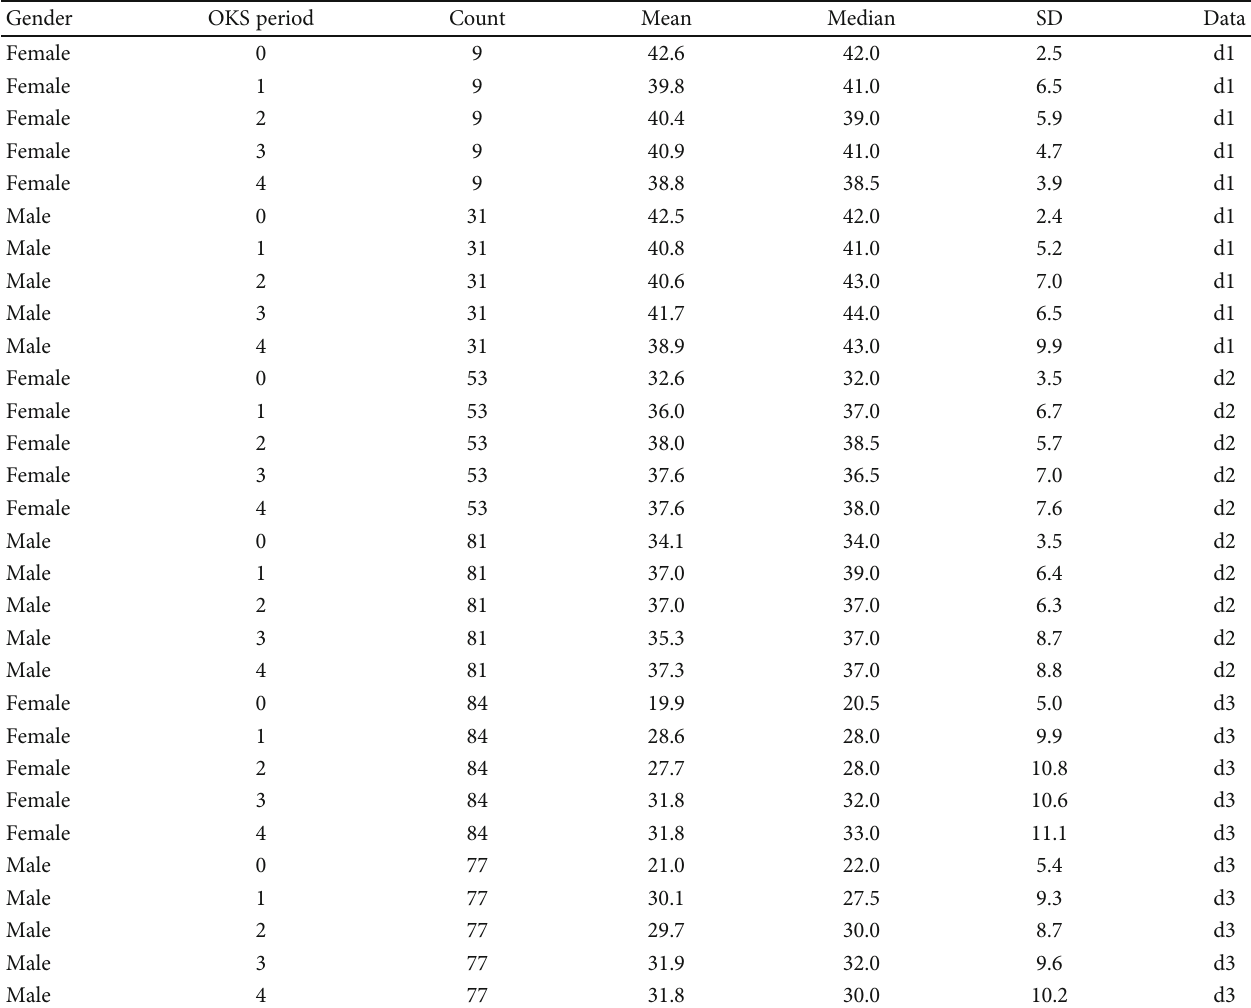
Table 5: Tabulated data for Figure